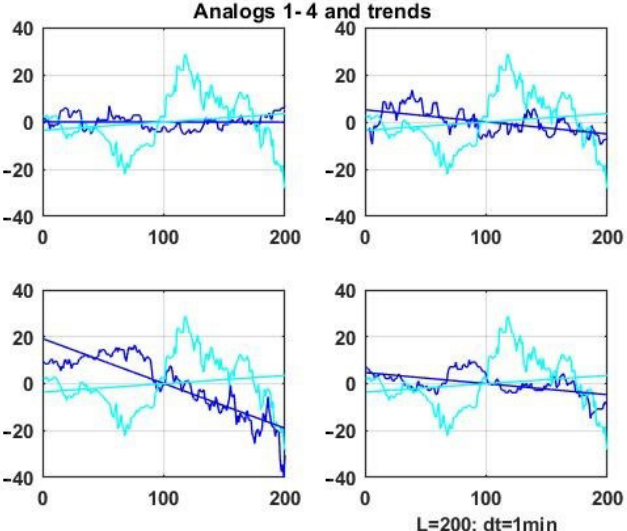
Figure 8. Analog windows for the first parameter of a multidimensional chaotic process by the Hotelling statistic.